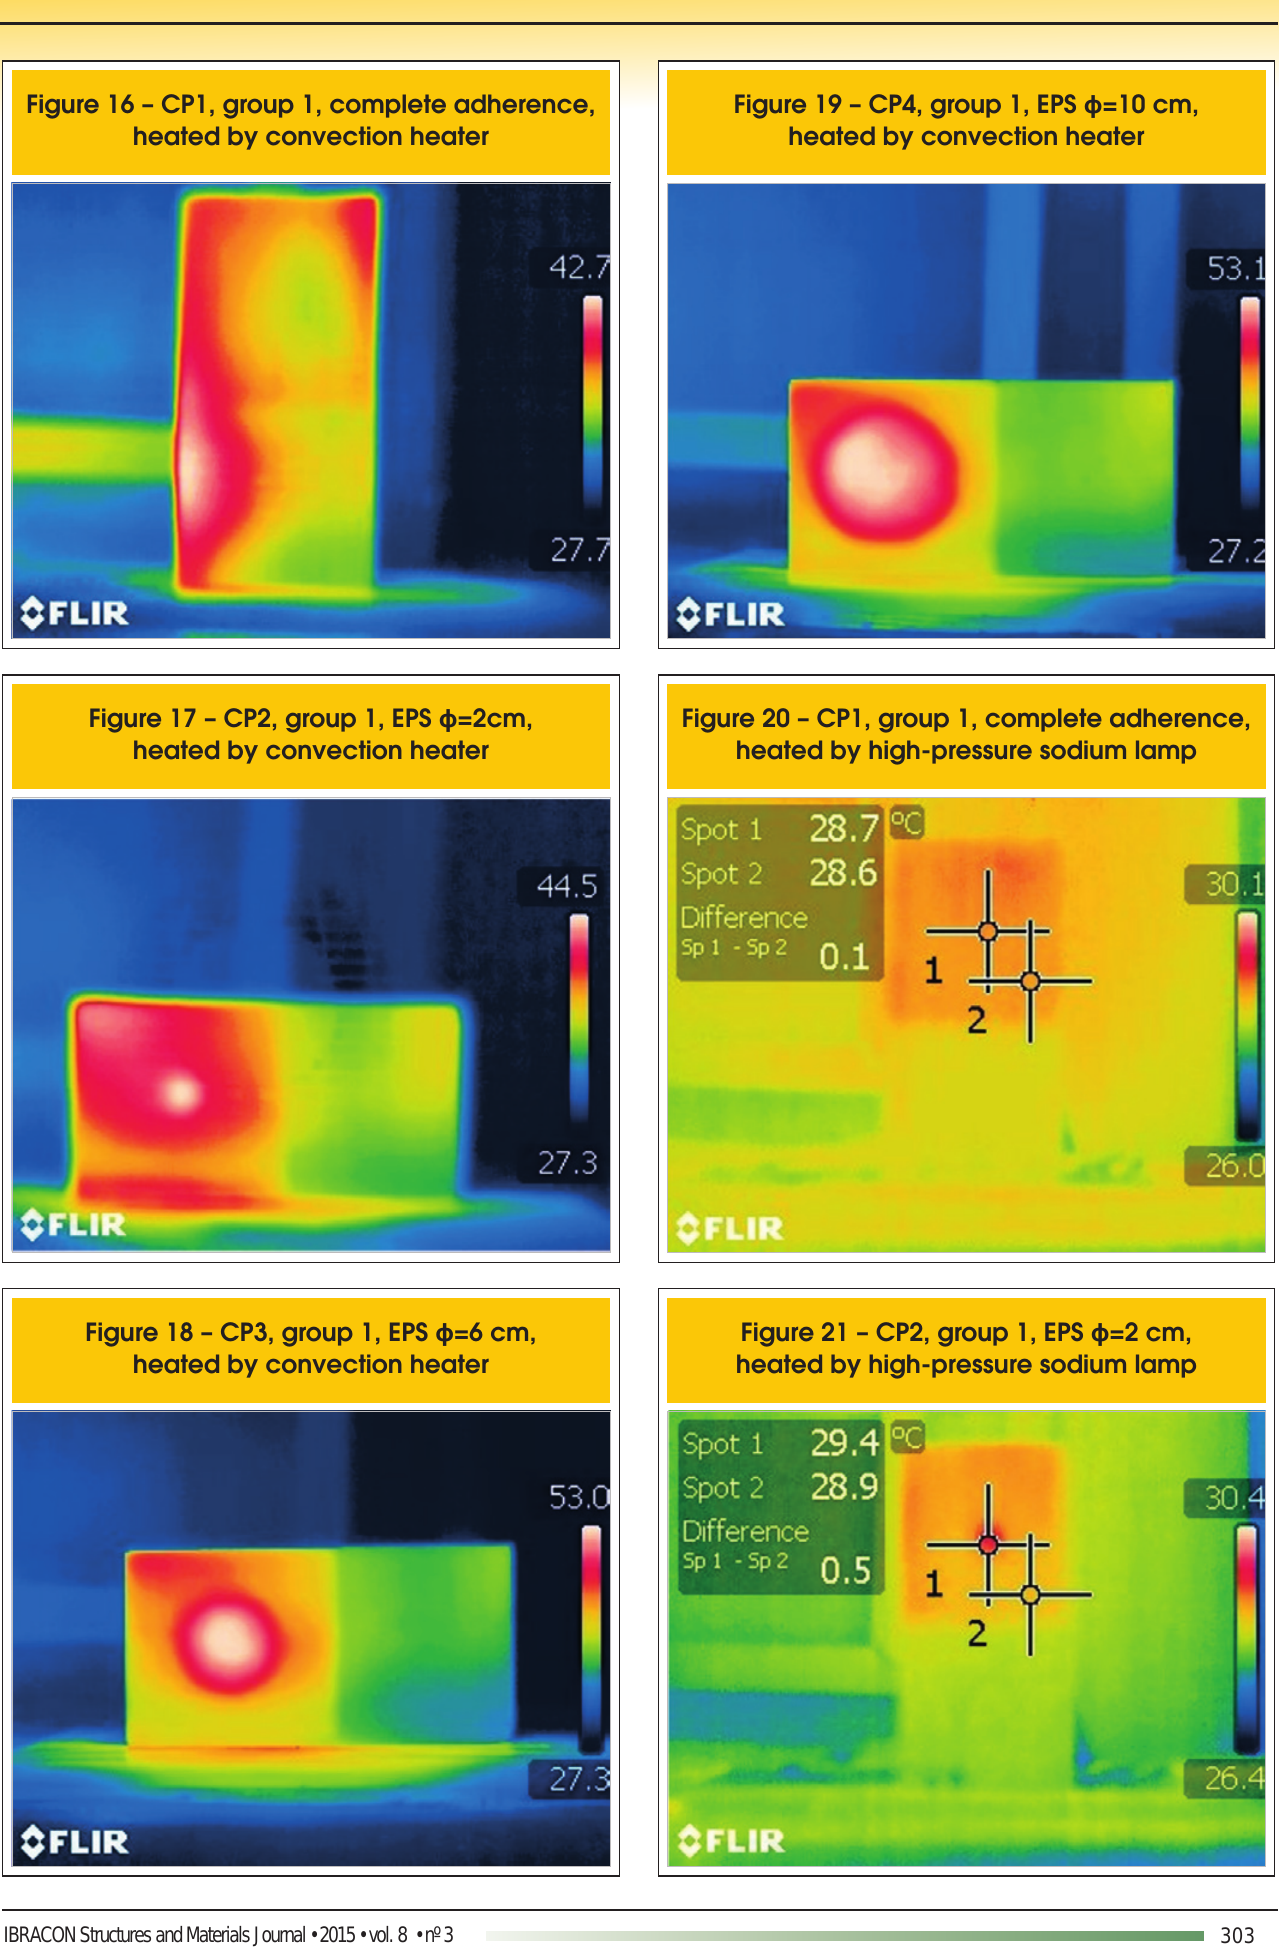
Figure 16 – CP1, group 1, complete adherence, heated by convection heater